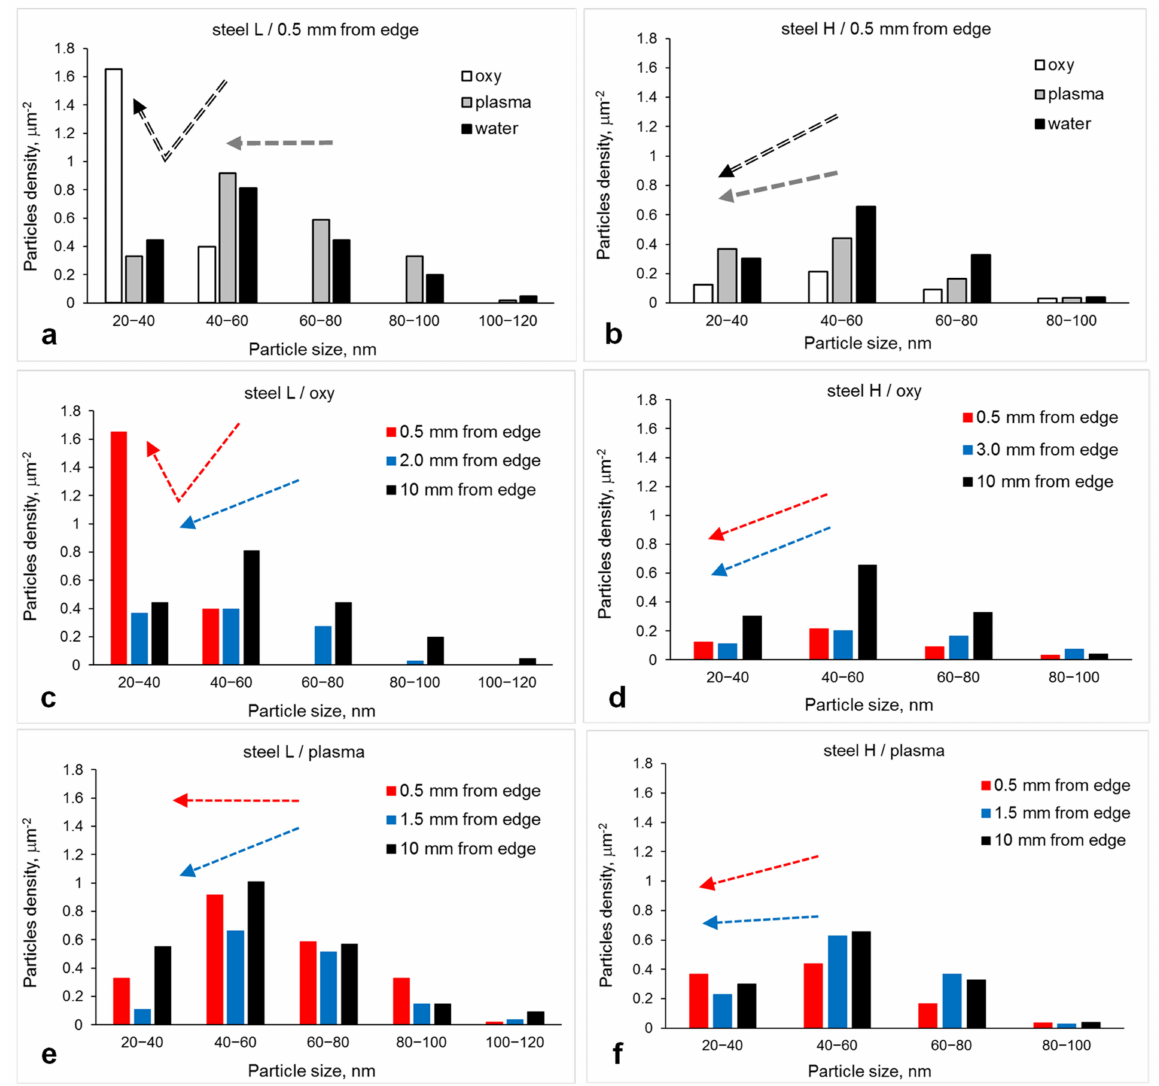
Figure 13. Fe 3 C particle number density distributions at 0.5 mm position from the cut edge in Steel ( a ) L and ( b ) H; arrows in ( a , b ) indicate the directions of distributions peaks shift for oxy-fuel and plasma cutting methods with respect to the distribution observed for the water jet cutting, and these in ( c – f ) indicate the directions of distributions peaks shift for 0.5/2.0/3.0/1.5 mm positions with respect to the distribution for the 10 mm